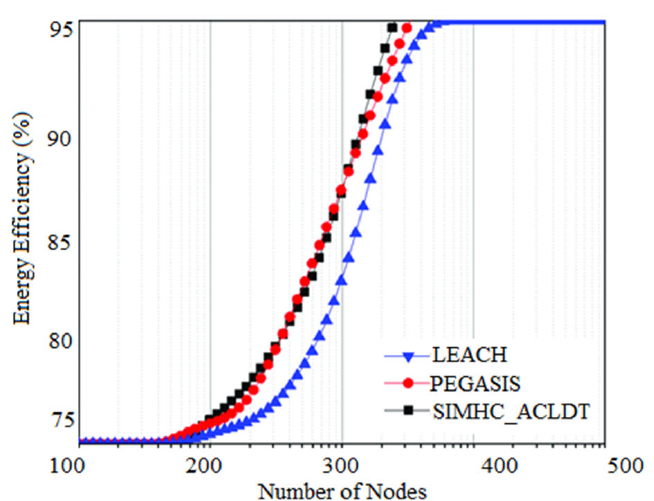
Figure 6. Comparative analysis of energy